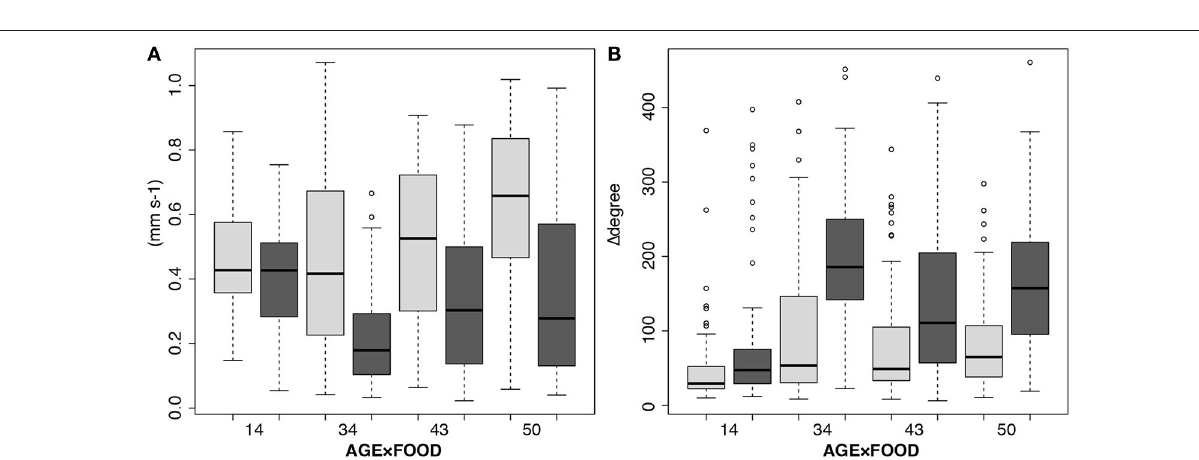
FIGURE 4 | Interaction boxplots showing age-dependent (days) larval response to food (copepod homogenate). The statistical analyses included 34 to 50-days-old planulae, but the 14-days-old are shown in the graphs for comparison. (A) Mean swimming velocity (mm s − 1 ), and (B) swimming behavior (sums of change of angles). Light gray, controls (no food); dark gray, after adding